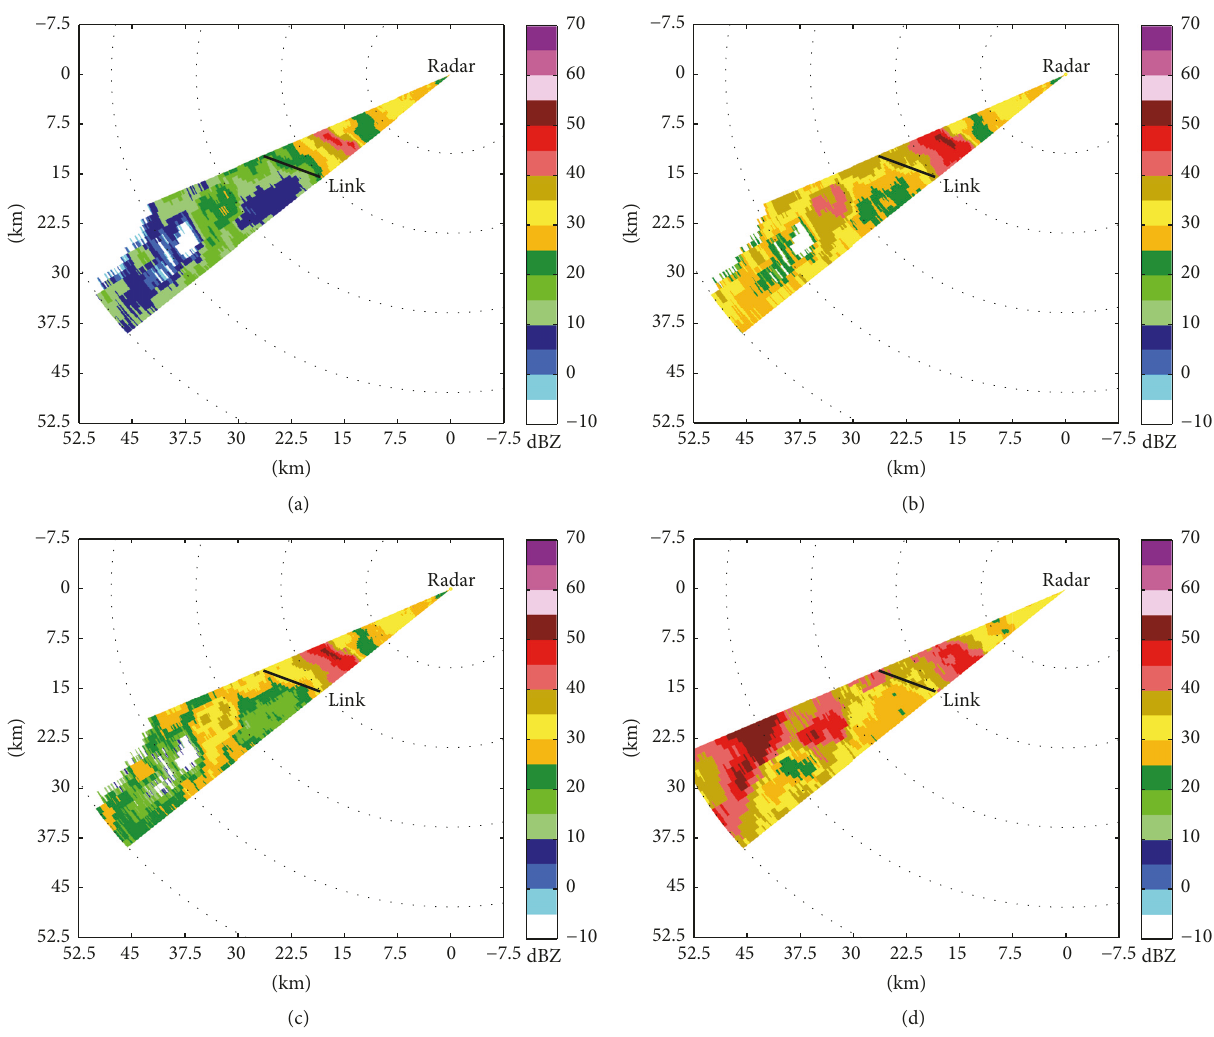
Figure 16: Reflectivity of (a) the XR before attenuation correction, (b) the XR after correction with ACML method, (c) the XR after correction with SC method at 0330 UTC, and (d) the SR at 0330 UTC, 1 June 2016. The microwave link is shown as black straight line in all figures.